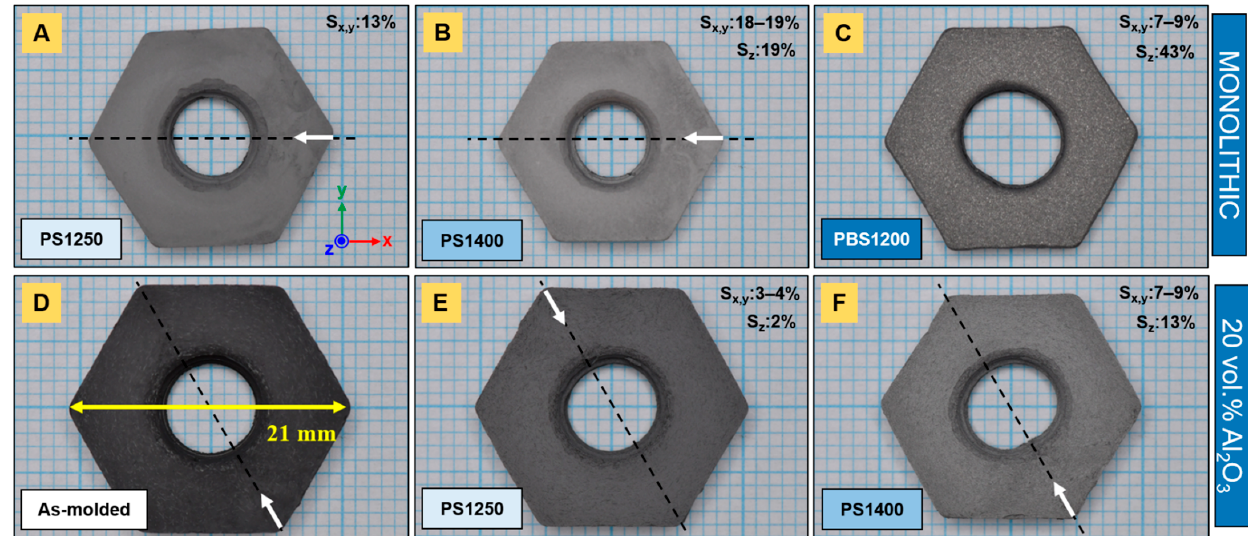
Figure 3. Sintered Ti 2 AlC nuts: ( A ) PS1250, ( B ) PS1400 and ( C ) PBS1200 of monolithic samples and ( D ) as-molded reference, ( E ) PS1250 and ( F ) PS1400 of N720 aluminosilicate fiber-reinforced (20 vol.%) composites. White arrows and dashed lines indicate the location of the gate and the axis parallel to the injection channel, respectively. Sintering shrinkage is given by the S values.